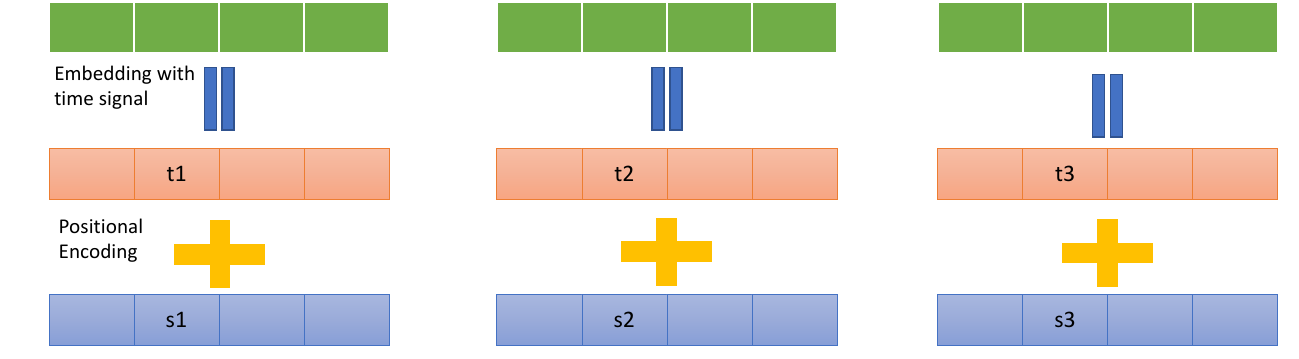
Figure 9. The specific architecture of positional